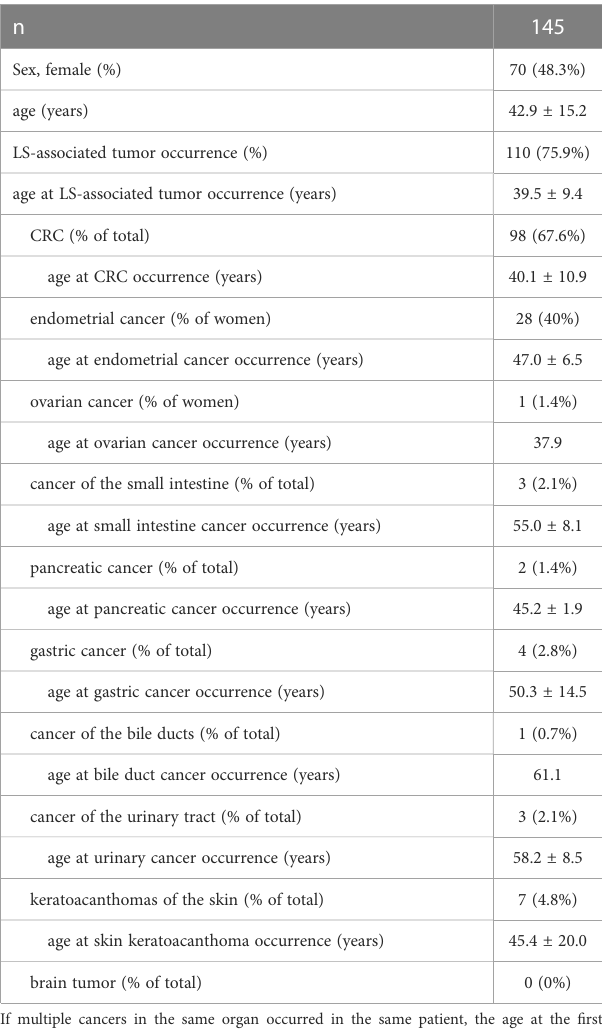
TABLE 1 Baseline characteristics of individuals with LS involved in this